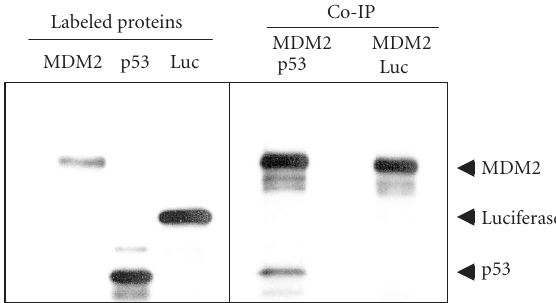
Figure 4. Coimmunoprecipitation of p53 and MDM2 using anti-MDM2 antibody-coupled agarose. MDM2, p53, and lu- ciferase were in vitro translated and 35 S-labeled using TNT- Coupled Reticulocyte Lysate System. p53 and MDM2 were com- bined and incubated at 30 ◦ C for 30 minutes. Co-IP was per- formed at 4 ◦ C for 2 hours with 60 µ L anti-MDM2 antibody- coupled agarose. Luciferase was used as a negative control pro- tein to incubate with MDM2. Eluted proteins were resolved on 4–12% SDS-PAGE and visualized by